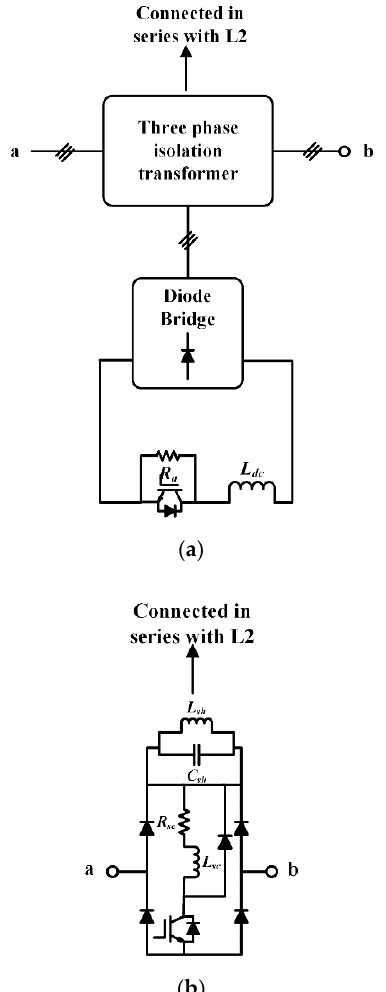
Figure 8. ( a ) The variable resistive type fault current limiter (VR-FCL) [29]; and ( b ) the parallel resonance type fault current limiter